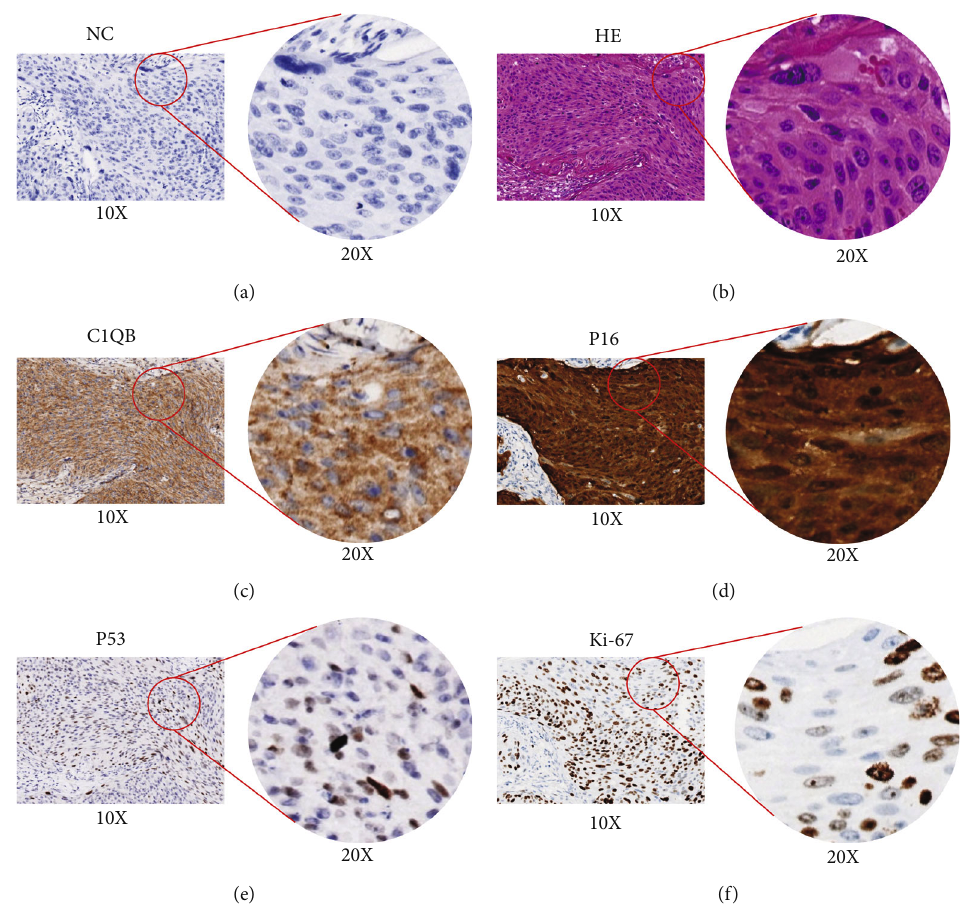
Figure 3: The expression of C1QB , P16, Ki-67, and P53 in cervical cancer. (a) Negative controls stained with PBS, (b) hematoxylin – eosin staining of cervical squamous cell carcinoma tissue, (c) C1QB is di ff usely stained in cervical cancer tissues, and the cytoplasm is positive, (d) P16 is di ff usely stained in cervical cancer tissues, and the cytoplasm and the cell nucleus are positive, (e) the expression of P53 in cervical cancer tissues, and the cell nucleus is positive, and (f) the expression of Ki-67 in cervical cancer tissues, and the cell nucleus is positive. NC, negative controls; HE, hematoxylin –